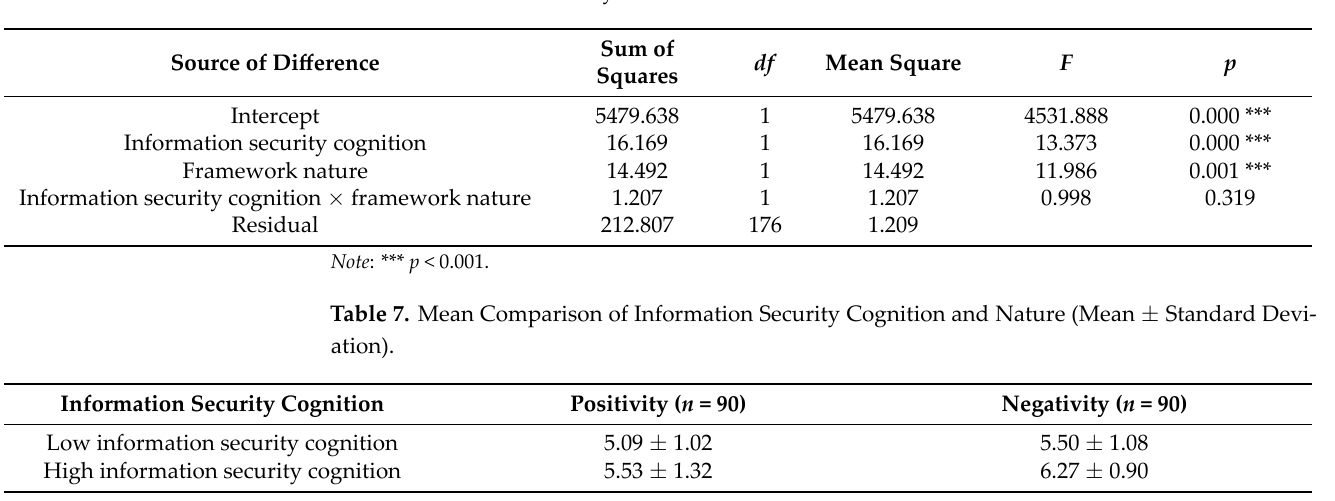
Figure 5. Mean Comparisons of Framework Properties and Situations. Table 6. Results of Two‑Way ANOVA.